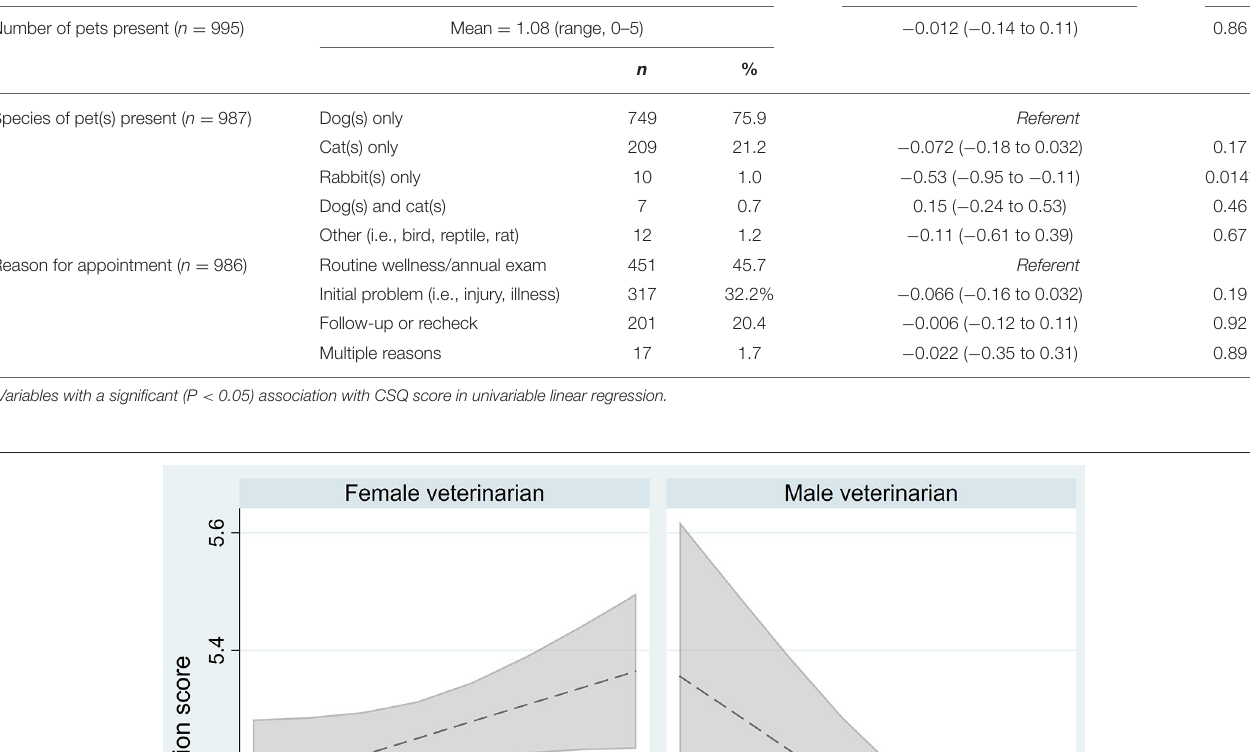
TABLE 4 | Description of appointments and predicted impact of appointment variables on Client Satisfaction Questionnaire (CSQ) score in univariable linear regression. Appointment characteristic